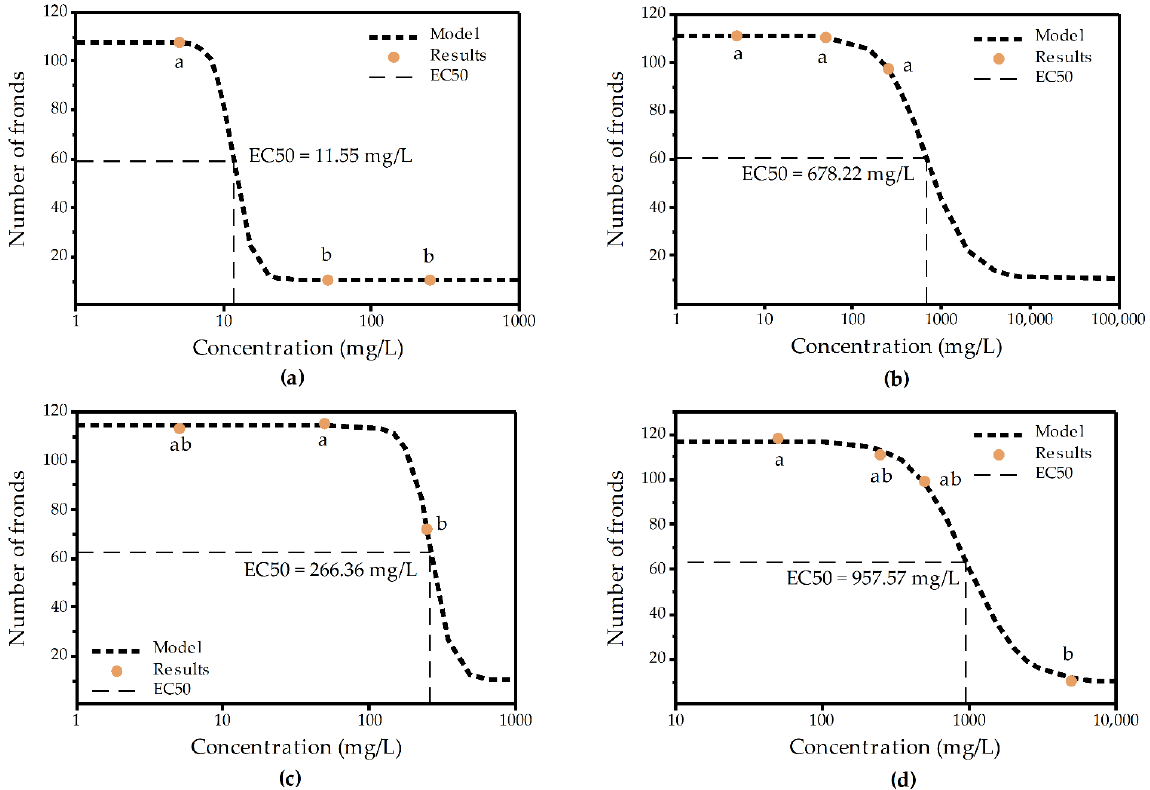
Figure 1. Dose–response curve of the number of fronds of Lemna minor and the concentrations of ( a ) D-glucosamine hydrochloride (G), ( b ) N-acetyl-D-glucosamine (NAG), ( c ) chitobiose dihydrochloride (2G) and ( d ) N-carboxymethyl chitosan (N-CMChi). Symbols with same letter do not present statistically significant differences (Supplementary Tables S1–S3).